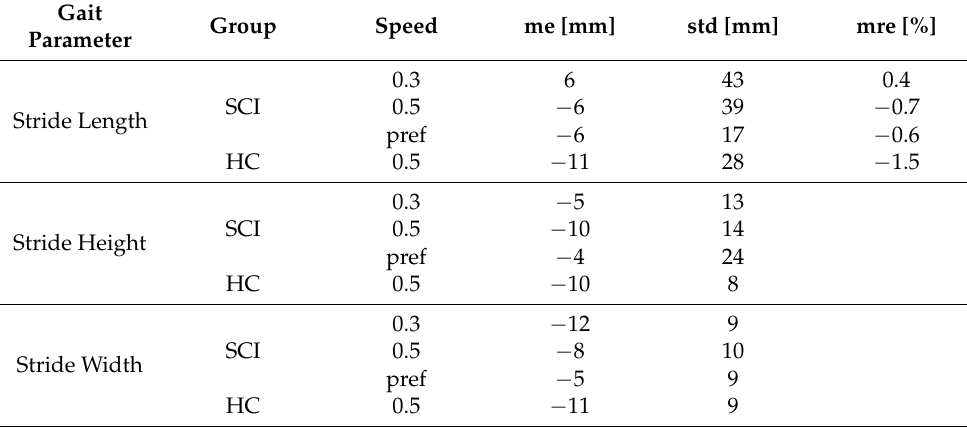
Table A2. Mean error (me), its standard deviation (std), and the mean relative error (mre) between the spatial gait parameters derived from the GRAIL and the inertial sensors. The values are reported for SCI patients and healthy controls (HC) and the speed levels of 0.3 m/s, 0.5 m/s, and preferred (pref) walking